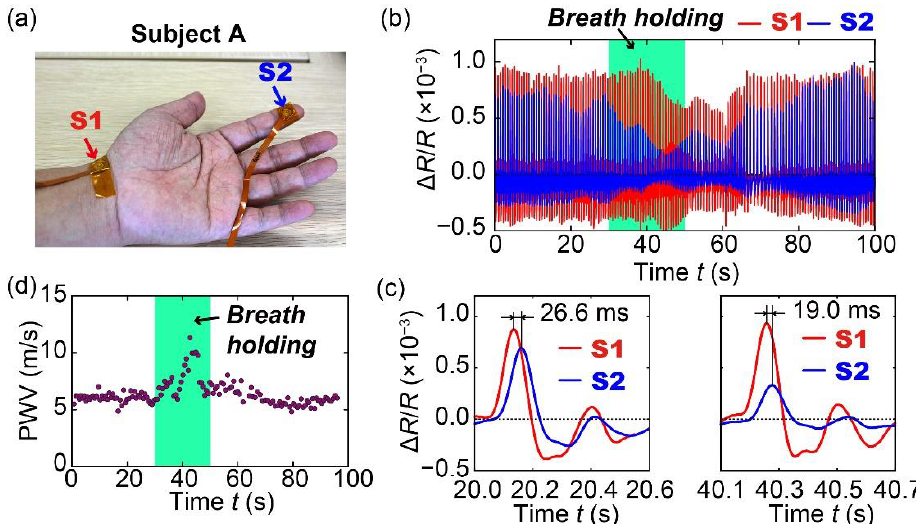
Figure 7. ( a ) Photograph of the sensors attached to the index finger and the wrist of subject A to measure the pulse wave velocity. ( b ) Pulse waves measured using the two sensors for 100 s. ( c ) Measured pulse waves before and during breath holding. ( d ) Measured PWV for 100 s. The results clearly show that breath holding can lead to increase in PWV.